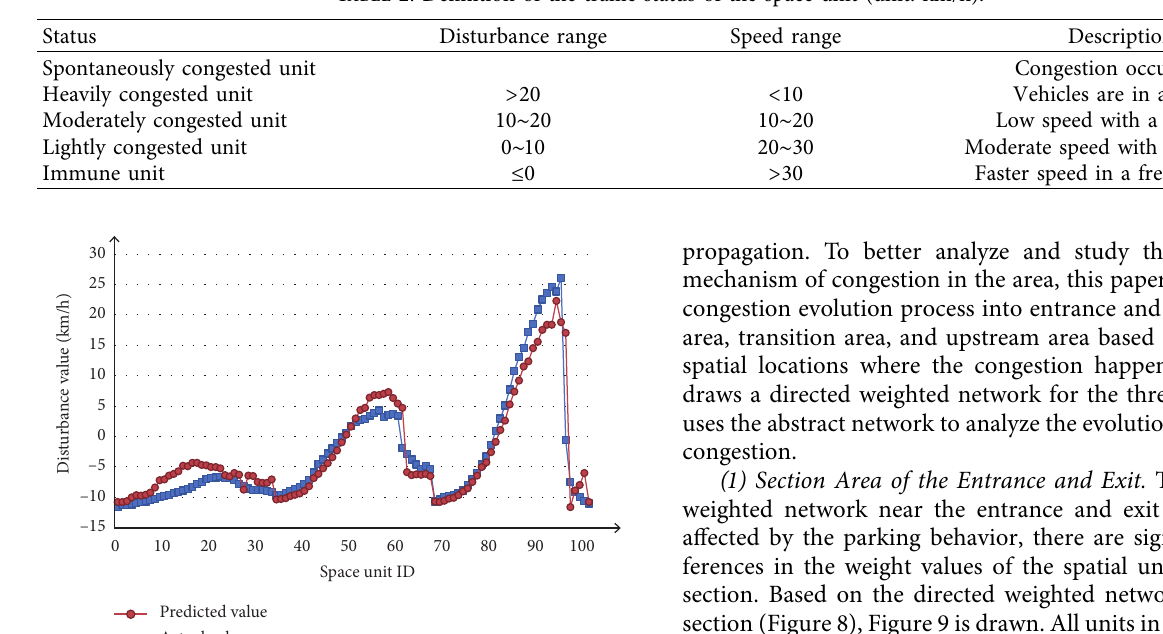
Table 2: Definition of the traffic status of the space unit (unit: km/h).